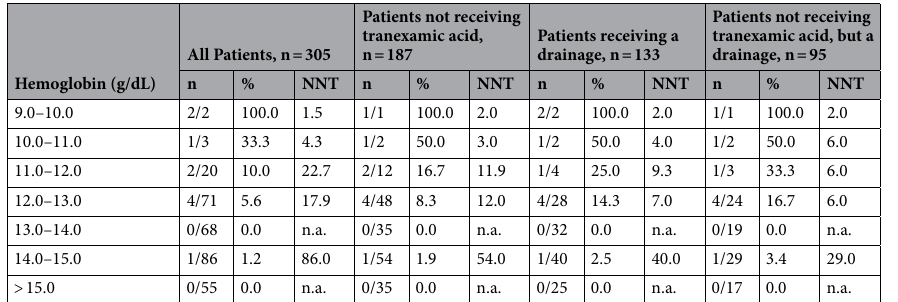
Table 5. Transfusion frequency in patients with different pre-operative hemoglobin levels and predicted number needed to treat (NNT) to prevent red blood cell transfusion by an iron infusion-induced increase of the preoperative hemoglobin of 1 g/dL. n.a. not